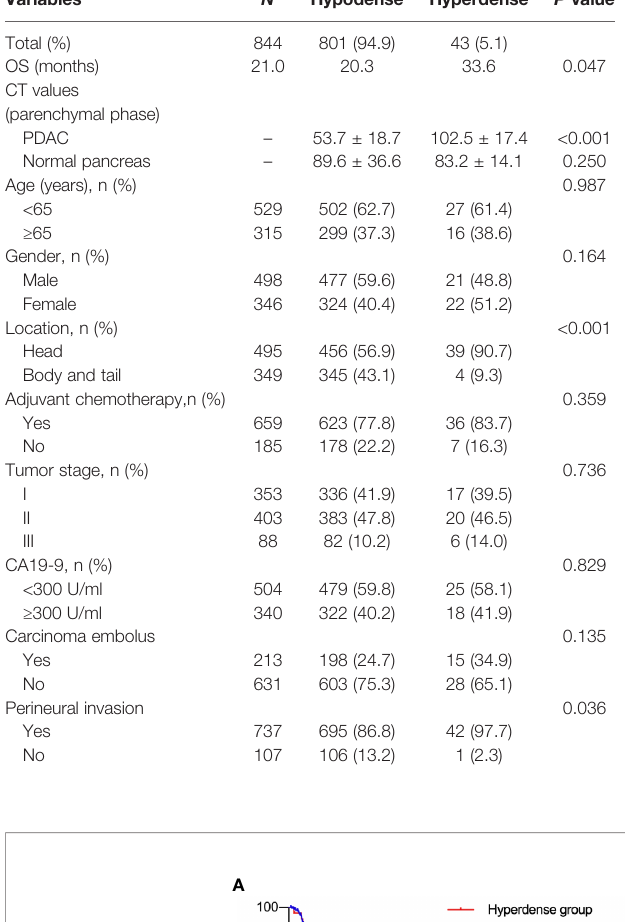
TABLE 1 | Patients and tumor characteristics.